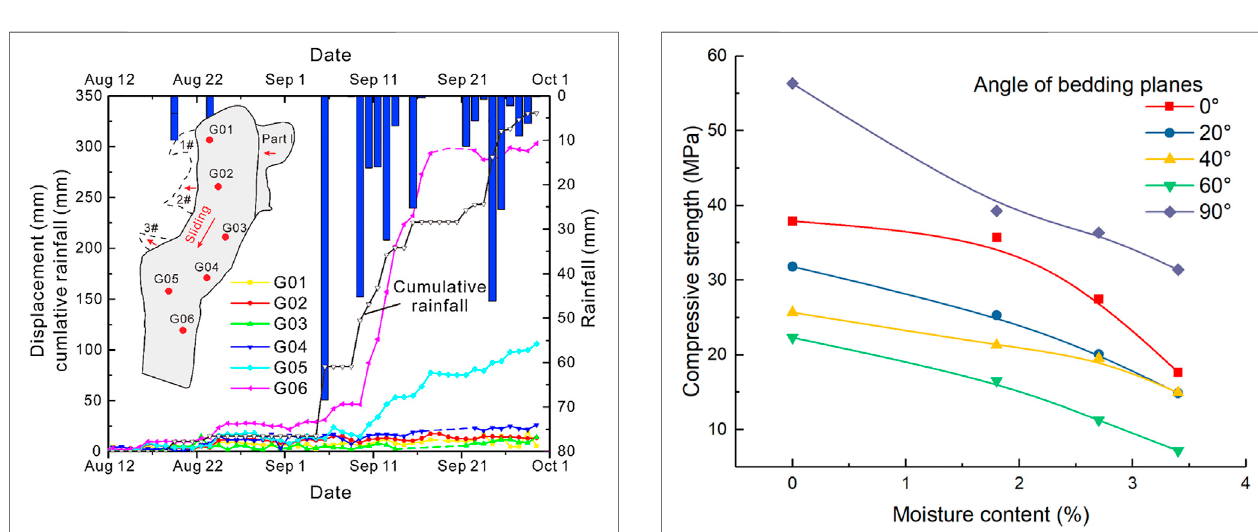
FIGURE 12 | Rainfall cumulative displacement of monitoring points and vs. time. FIGURE 13 | In fl uence of moisture content on the compressive strength of the shales with different angles of bedding planes.